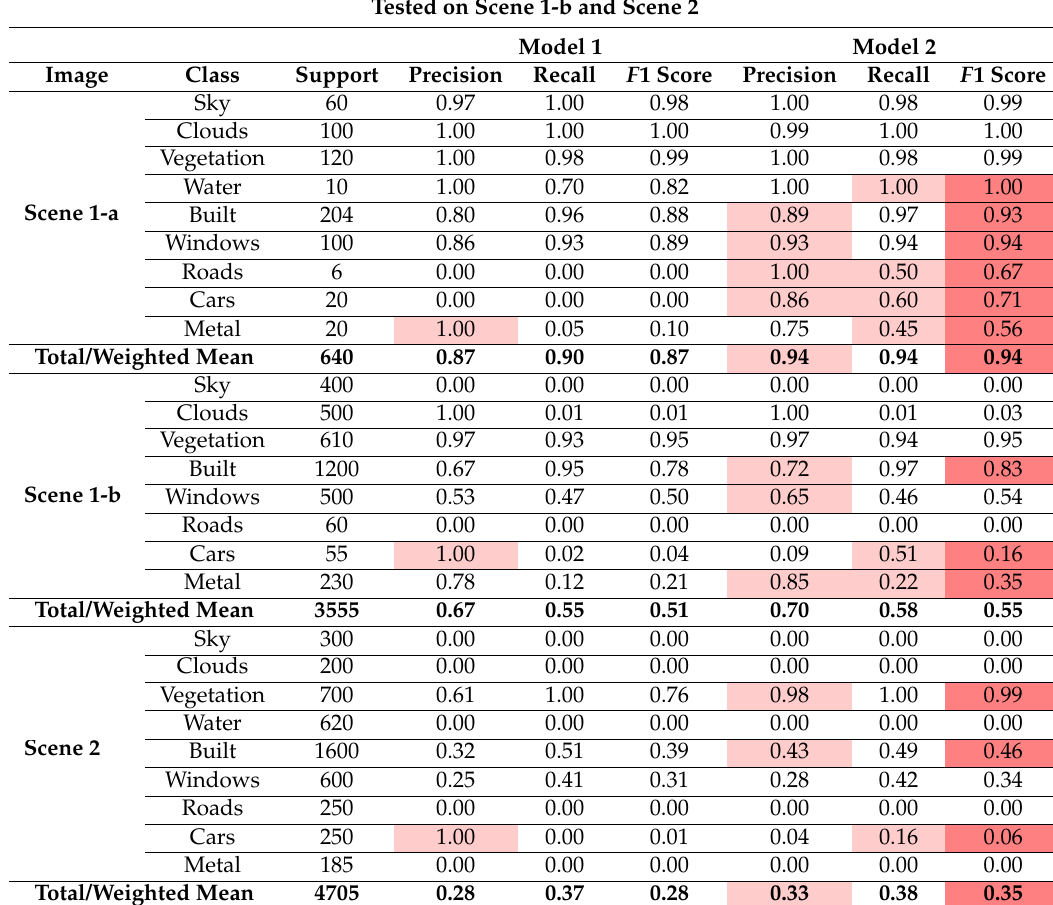
Table 4. Performance of Model 1 and Model 2, trained on Scene 1-a and transferred to Scenes 1-b and 2, computed from the confusion matrices provided in Appendix A Figure A4. Highlighted cells compare results between the models with dark red highlighted cells indicating greater F 1 score by at least 5% and light red highlighted cells indicate greater precision or recall by at least 5%. In general, Model 2 shows enhanced performance over Model 1 when transferred to Scenes 1-b and 2; however both models performed significantly worse when transferred relative to training on each image separately. On a per class basis, Model 2 shows enhanced performance at classifying human-built structures than Model 1. The classification of Vegetation pixels remained consistently accurate and precise by both models in all testing cases. The inability of both models to classify any Sky and Clouds pixels in the transfer to Scene 1-b relative to their almost perfect classification in Table 1 is evidence of the significant dependence of illumination change on transfer